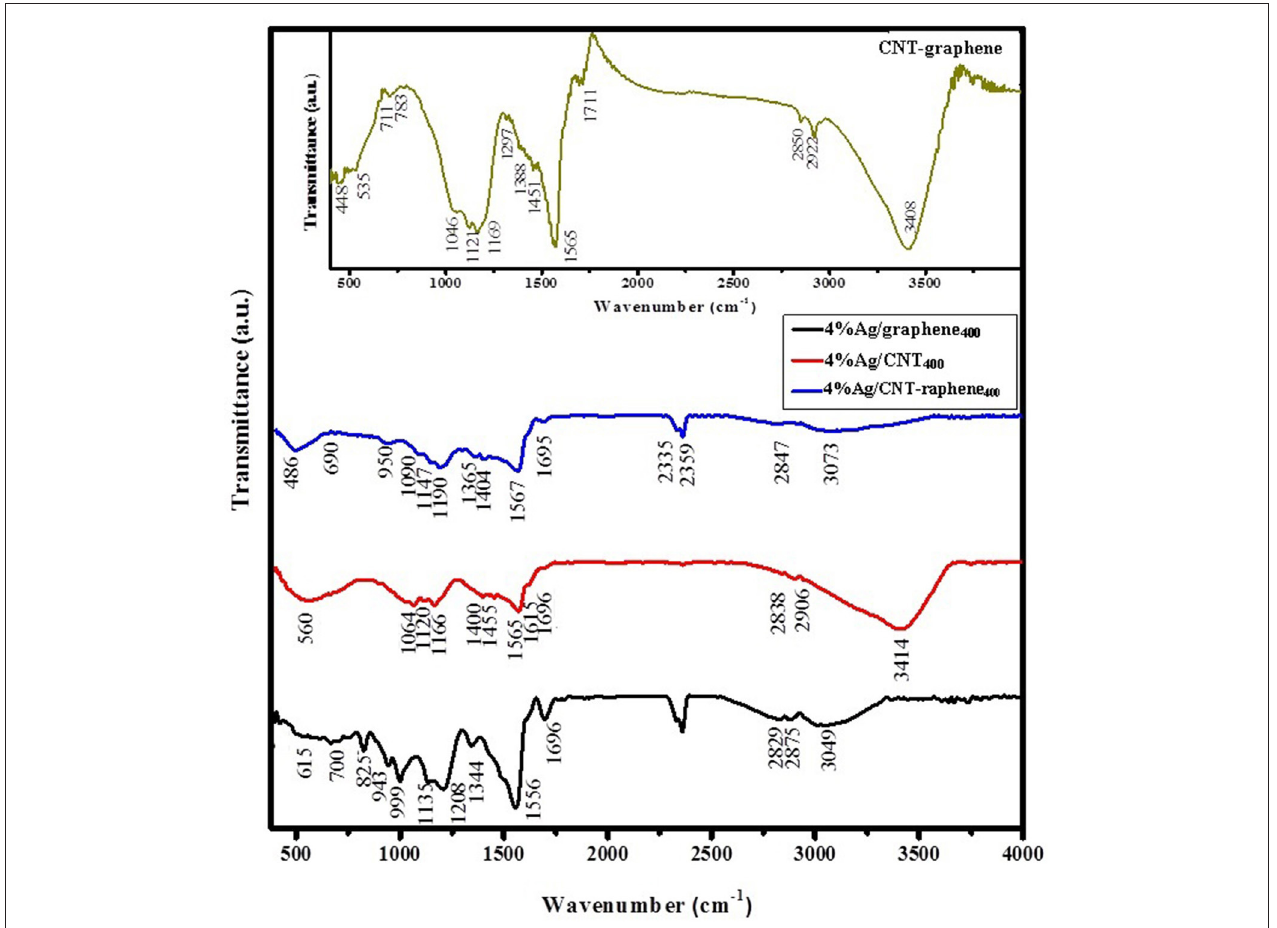
FIGURE 5 | FTIR spectra of 4%Ag/graphene 400 , 4%Ag/CNT 400 , and 4%Ag/CNT-graphene 400 in the 400–4,000 cm − 1 range, in addition to the spectrum of CNT-graphene as